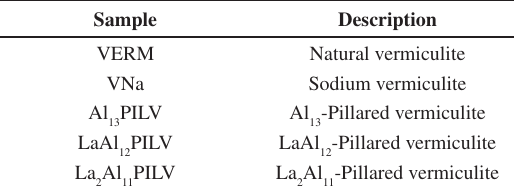
Table 1. Description of the samples.